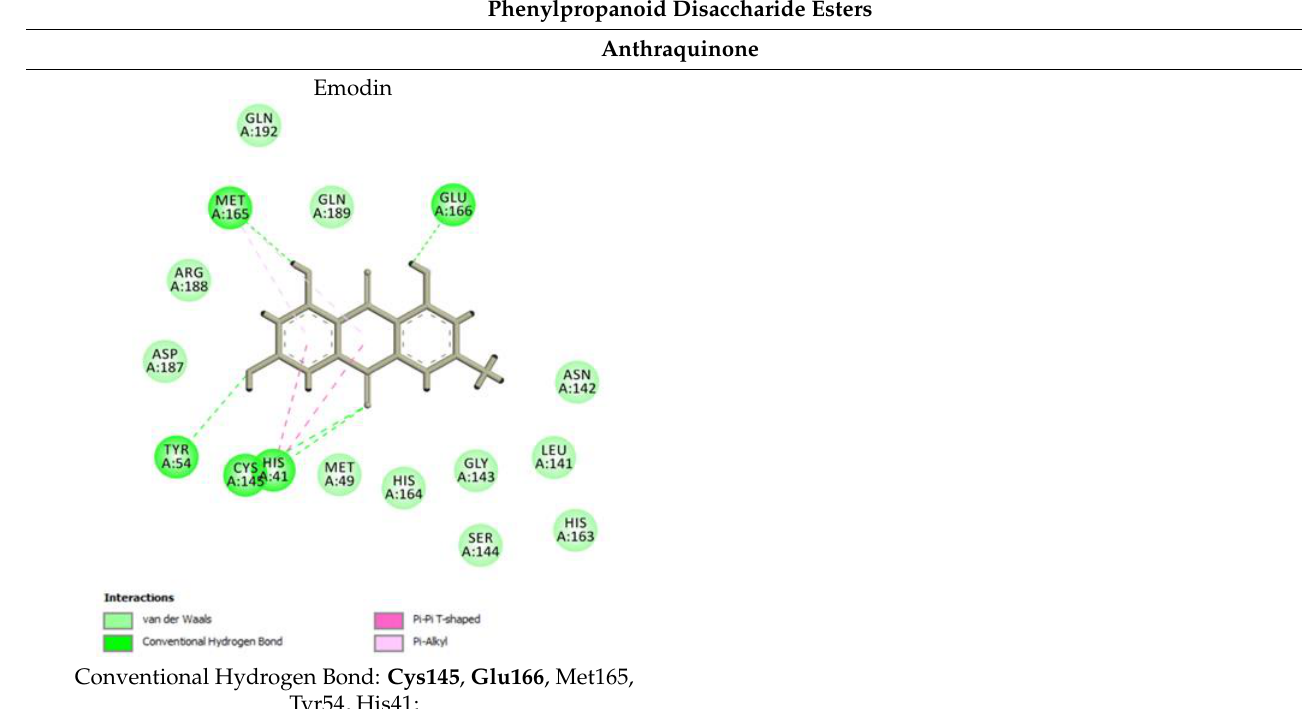
Table 2. 2D interactions diagrams of presumably not good candidates for Mpro inhibitors.